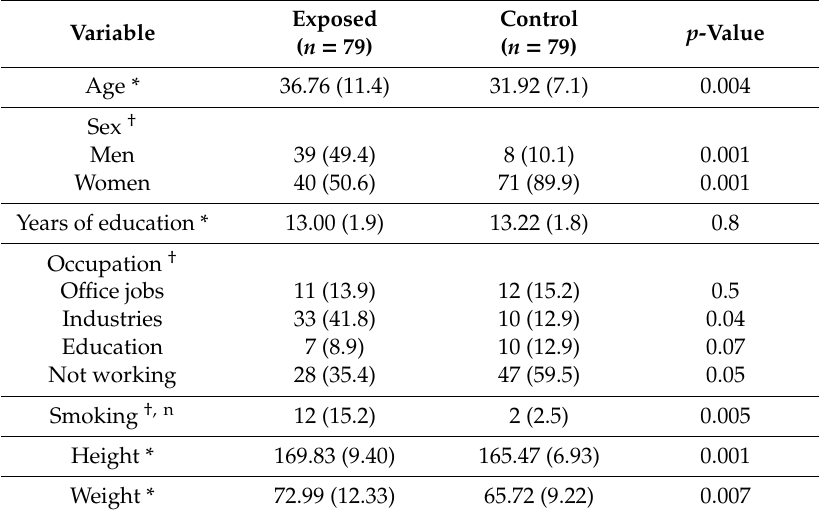
Table 1. General characteristics of the two study